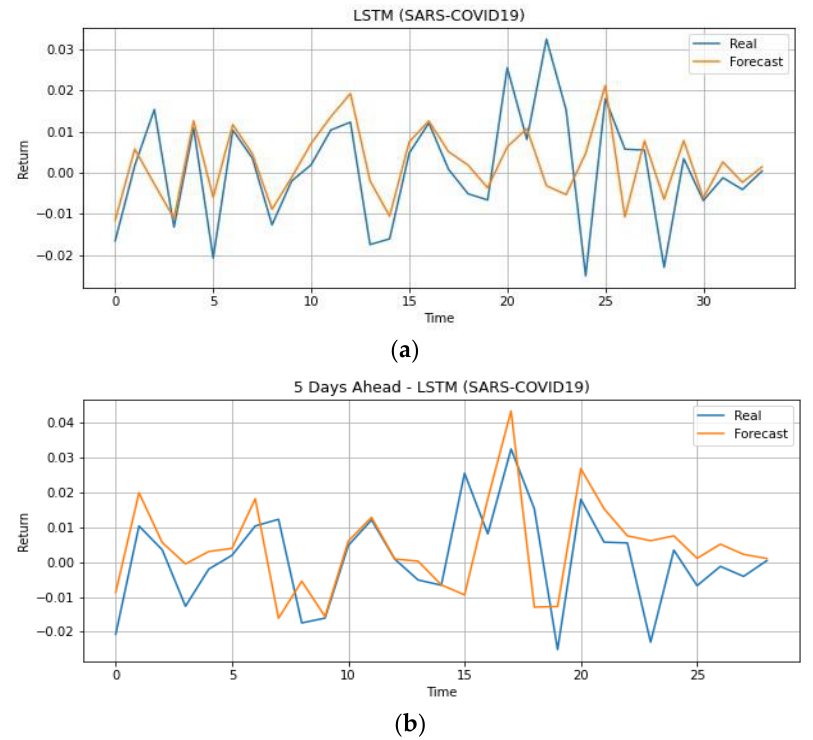
Figure 16. LSTM (SARS + COVID-19) Forecasting Result After COVID-19 Pandemic with One-Day- (a) and Five-Day-Ahead (b) Forecast.